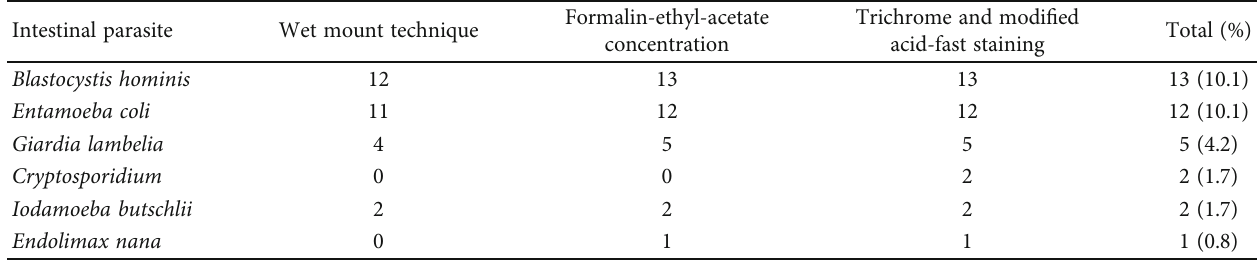
Table 1: Detected parasites among intellectually disabled individuals in Bandar Abbas County, Southern Iran, by di ff erent detection methods.